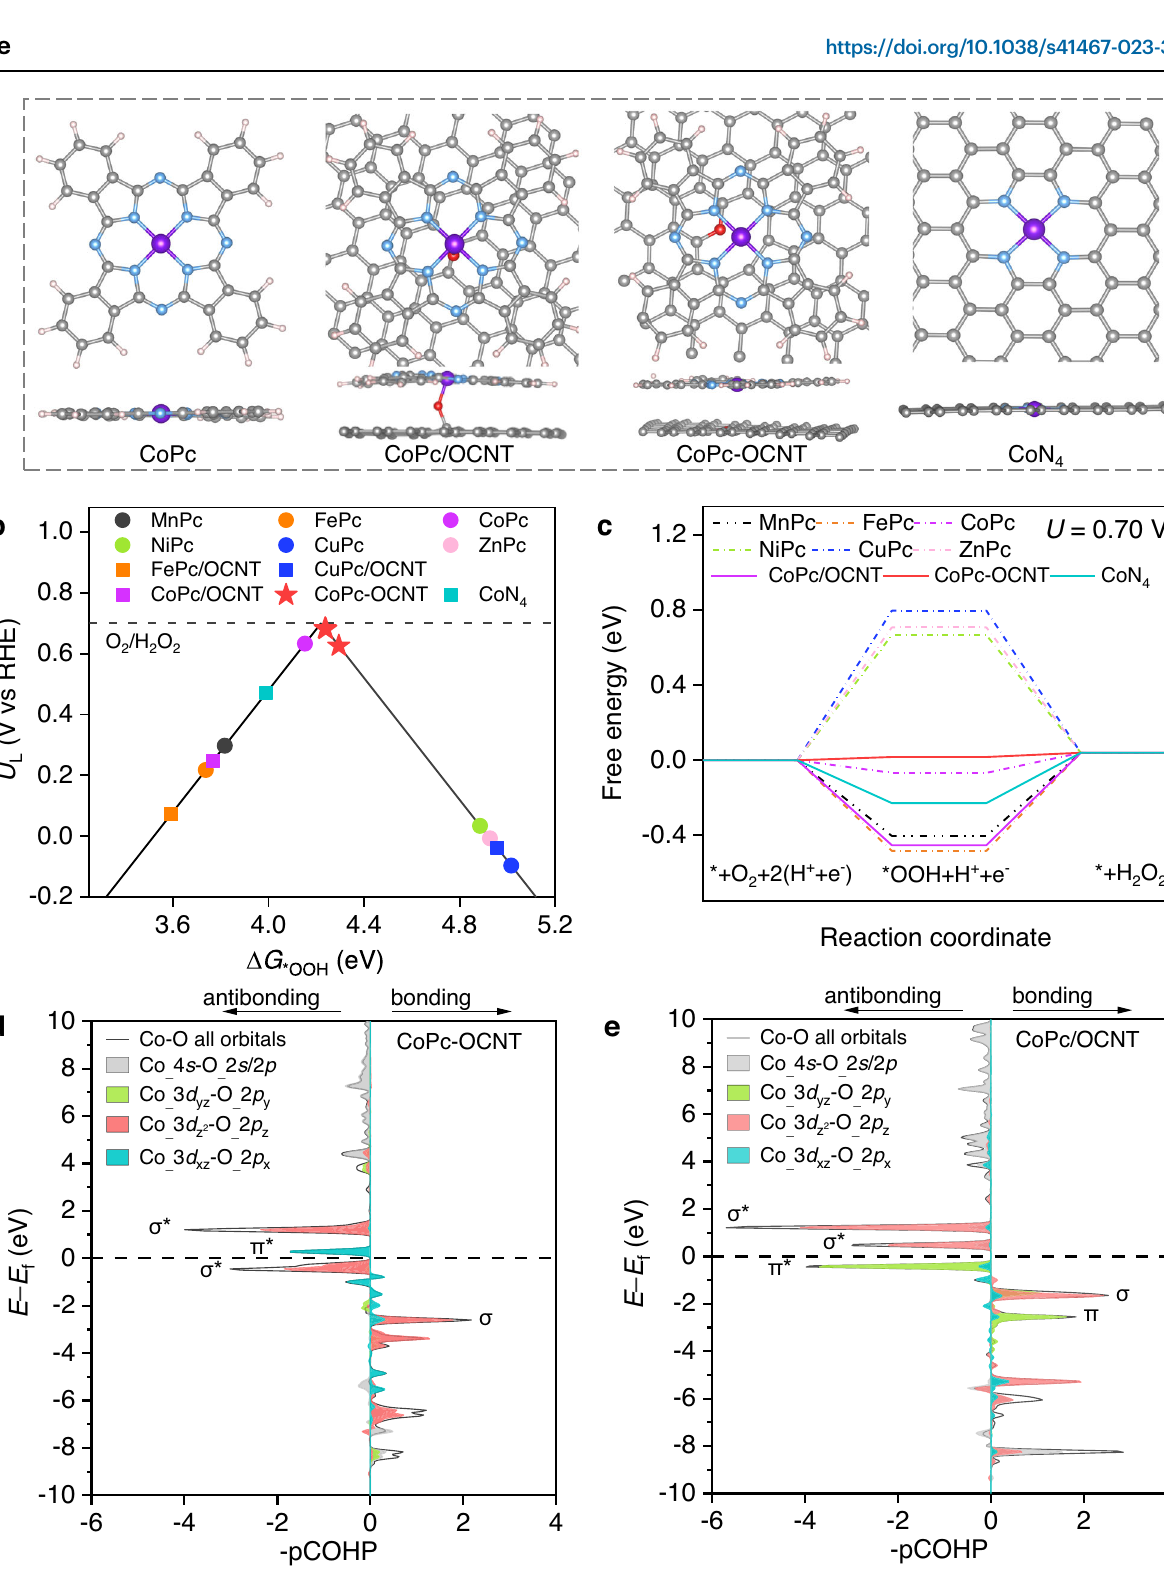
at 0.7V vs RHE, where * and *OOH denote an unoccupied active site and adsorbed *OOH, respectively. d – e Projected crystal orbital Hamilton populations (pCOHP) between Co and p-orbital of O of *OOH on CoPc/OCNT and